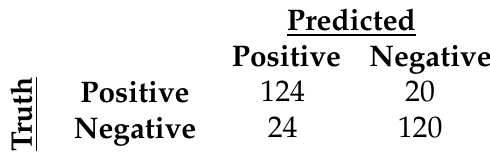
Figure 26. HybridEnsNet 3 confusion